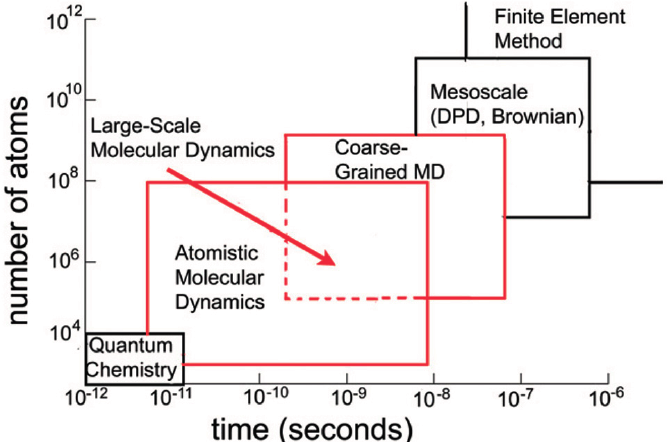
Figure 1. Modeling and simulation methods and corresponding system sizes and times. Reprinted with permission from